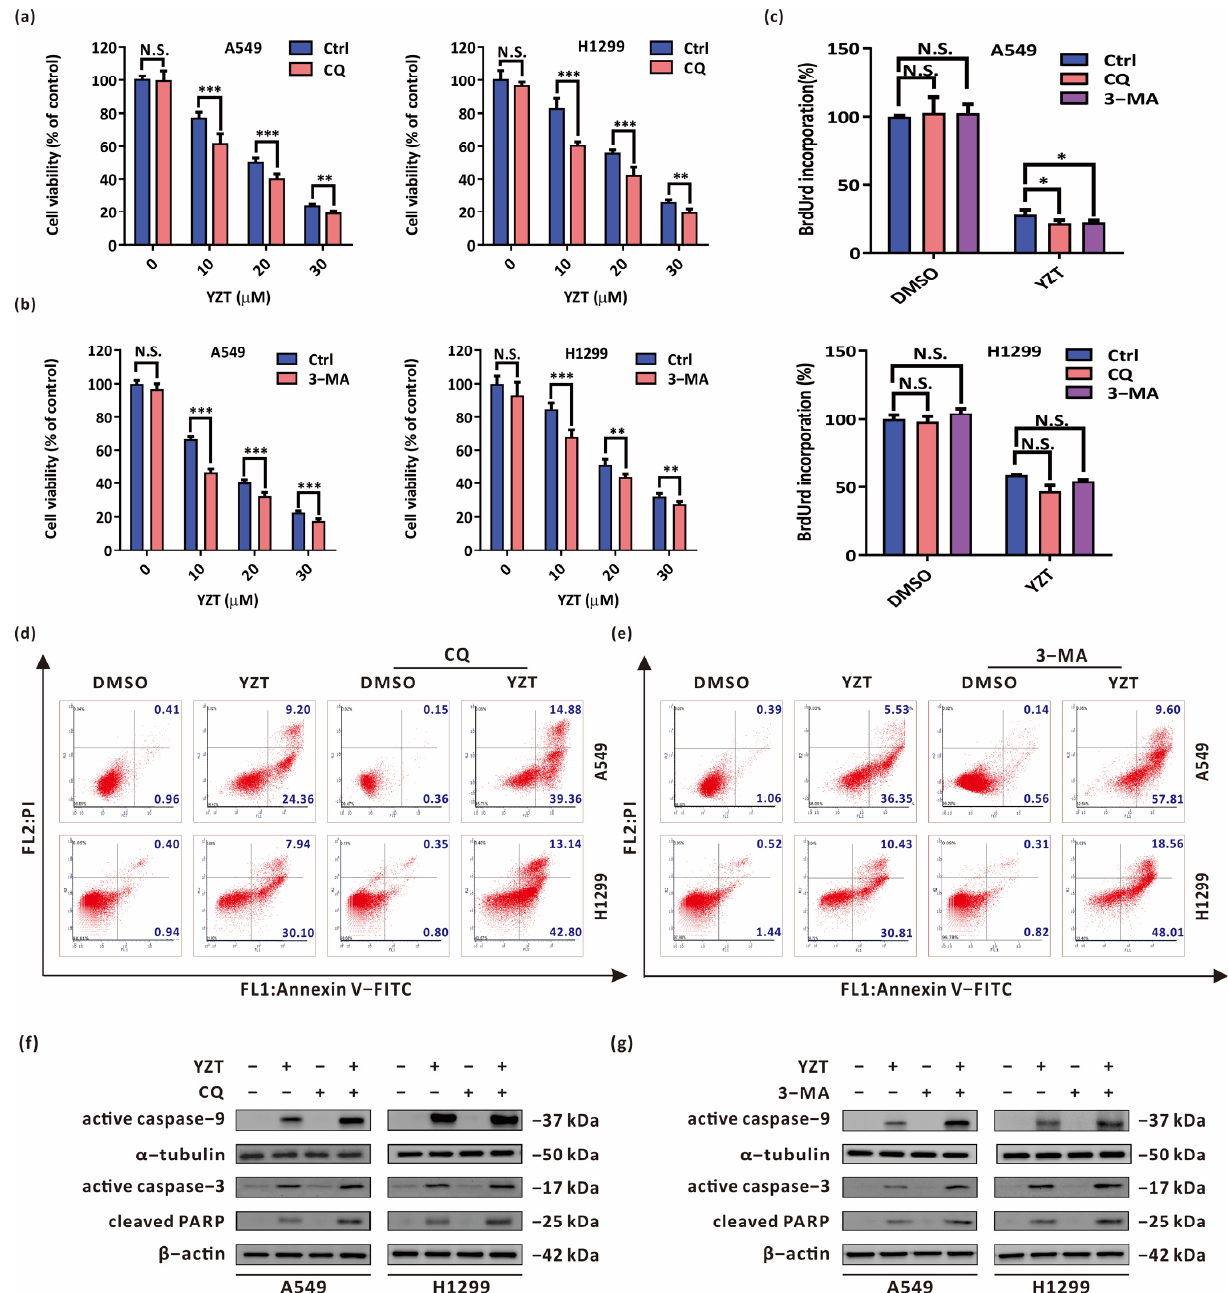
Figure 4. Autophagy blockade reinforces the anticancer activities of Compound YZT. ( a , b ) CCK-8 assay indicated that the combination of YZT with CQ ( a )/3-MA ( b ) strengthens the inhibitory action on cell viability compared with YZT alone. ( c ) Cell proliferation was measured by BrdU labeling detection. ( d , e ) Annexin V-FITC/PI apoptosis assay indicated that combined administration of YZT with CQ ( d )/3-MA ( e ) enhances cell apoptosis compared to YZT alone. ( f , g ) The expression of active caspase-9, active caspase-3 and cleaved PARP were examined by western blotting. Significant dif- ferences were designated as * p < 0.05, ** p < 0.01 and *** p < 0.001.